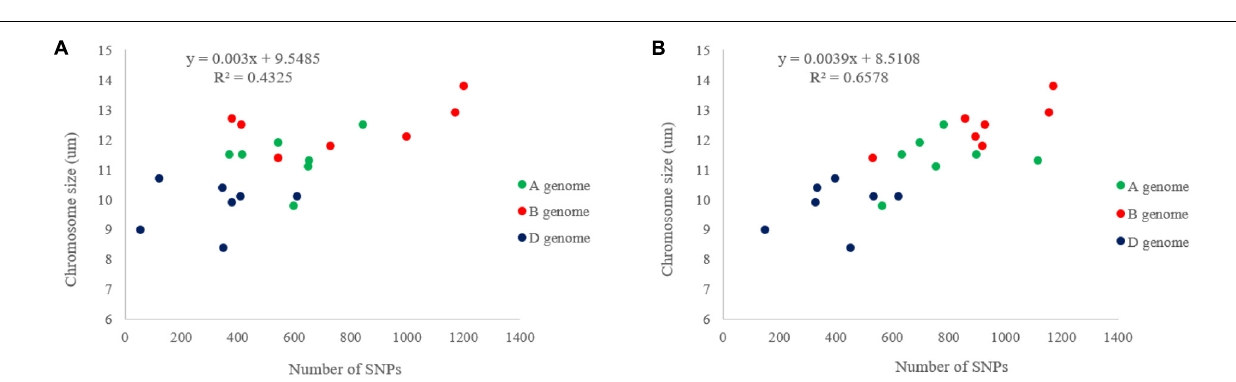
FIGURE 1 | (A) Numbers of SNPs and (B) average marker intervals (cM) of all 21 wheat chromosomes based on CSSS and W7984 reference assemblies.